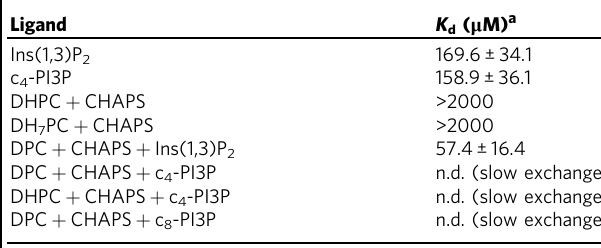
Table 3 Af fi nities of SNX3 for lipid molecules and